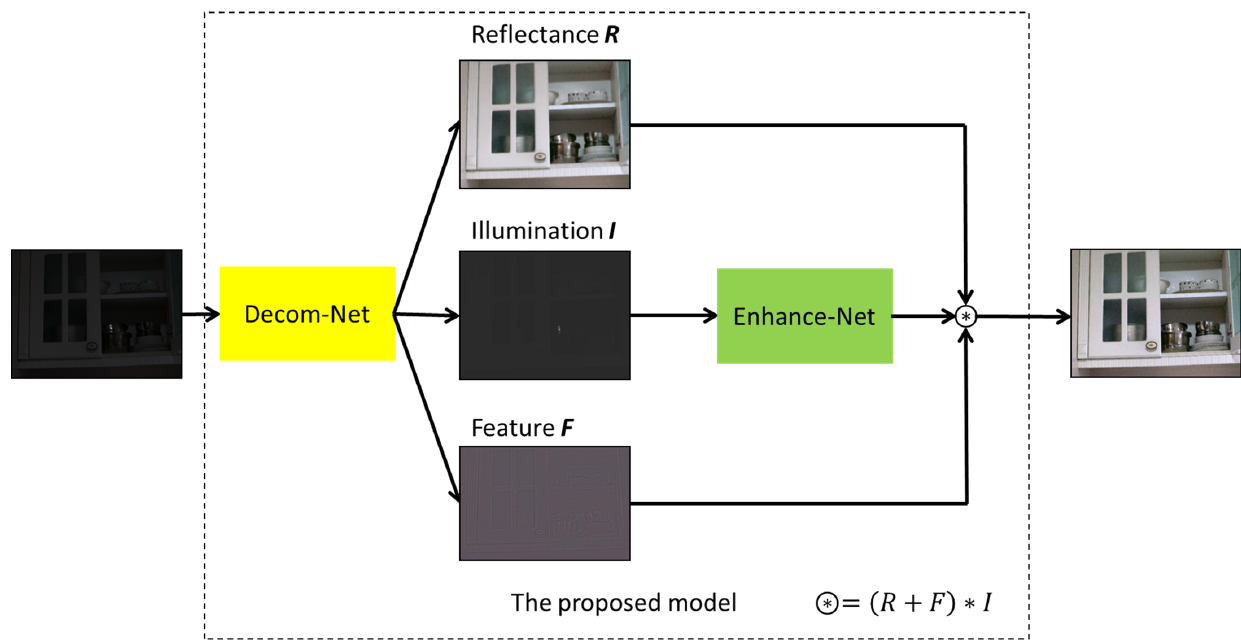
Figure 1. The framework of the proposed model.